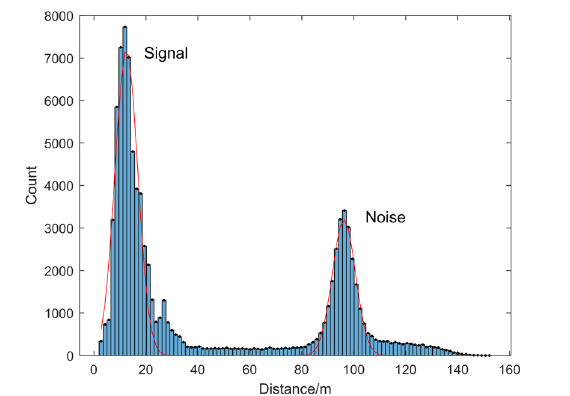
Figure 3 . Histogram of the photons KNN distance.